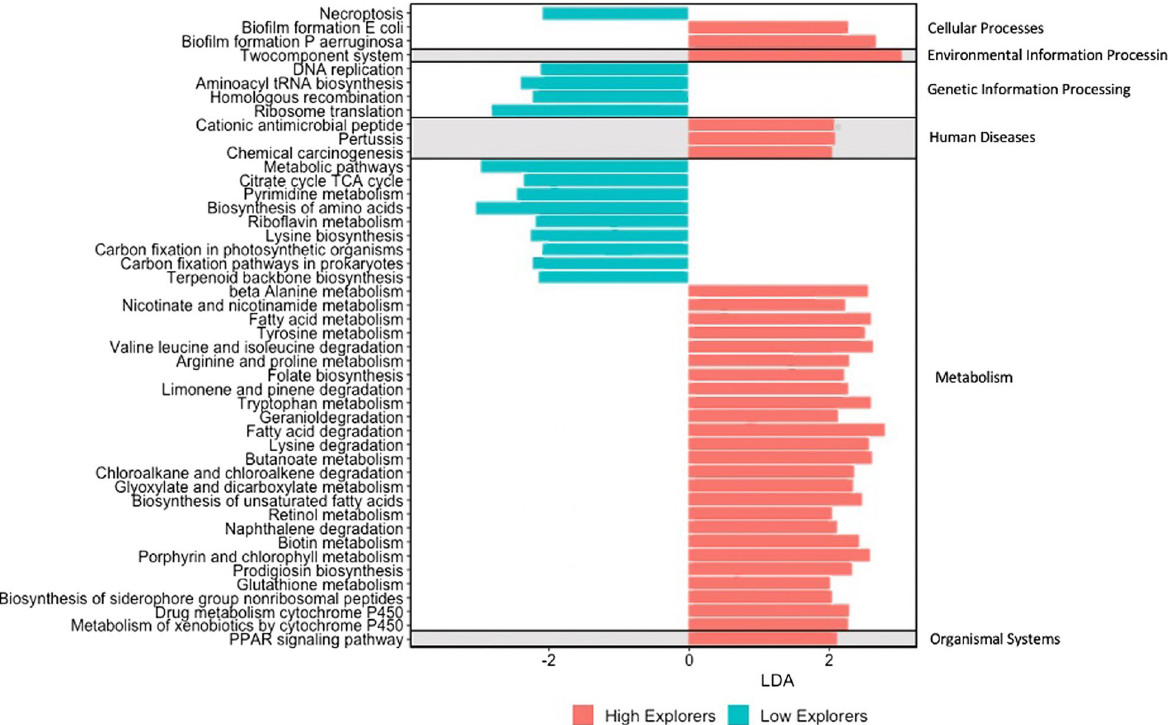
Fig. 3 Linear Discriminant Analysis Effect Size results identifying functional pathways differentially abundant in the gut microbiomes of high and low